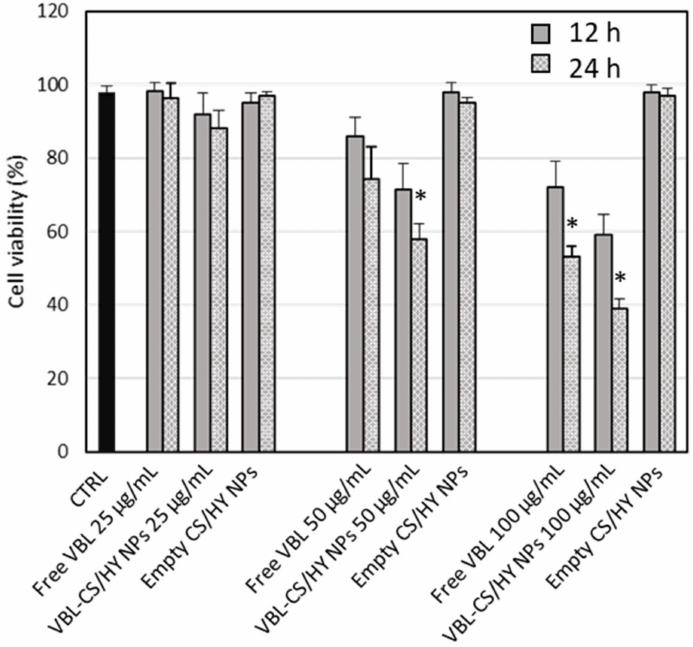
Figure 7. Dose-dependent cytotoxic effect of free VBL and VBL-CS/HY NPs against K-562 cells at different exposition times and doses. Drug cytotoxic effect is expressed as percentage of cellular viability. CTRL accounts for untreated cells, and showed a cell viability always ≥ 97%. Results are presented as the means of three different experiments (6 replicates for each point) ± S.D. * p < 0.05 versus free